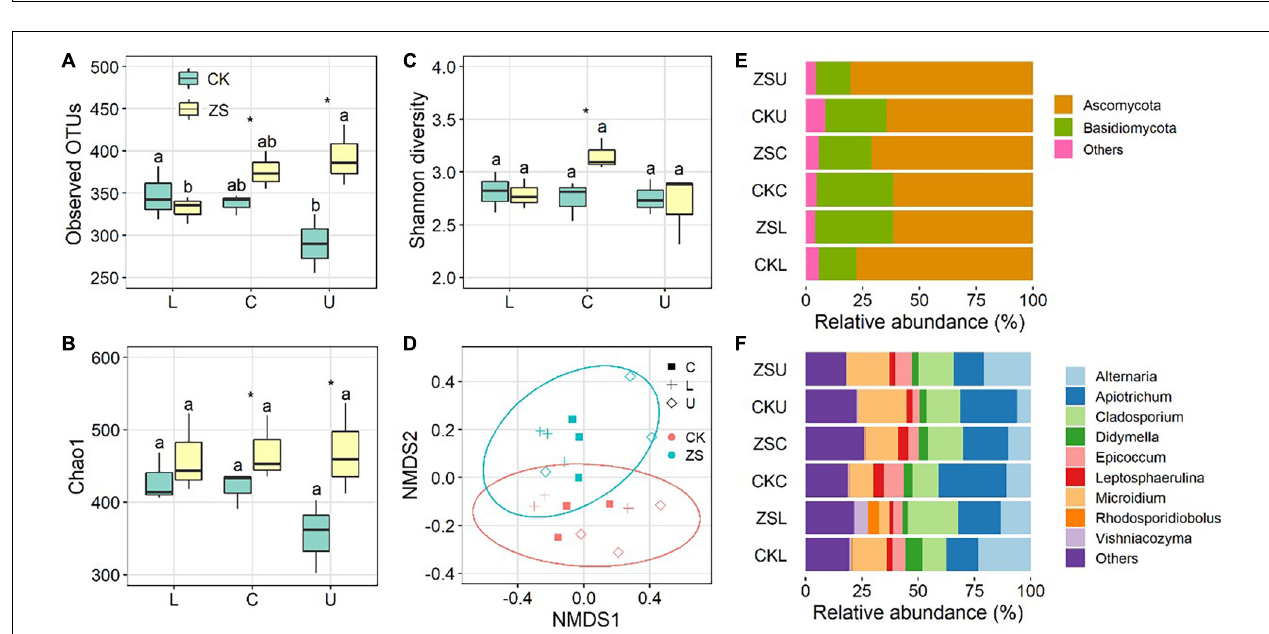
FIGURE 1 | Conceptual graph showing the layout of plots cultivating Yunyan97 and “cherry-red” Yunyan97 fields in the field.